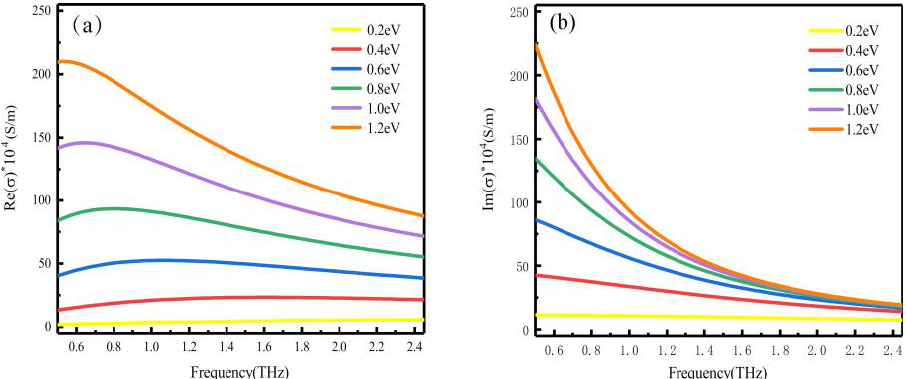
Figure 2. ( a ) The real and ( b ) the imaginary parts of the graphene conductivity with the Fermi level changing from 0.2 eV to 1.2 eV.